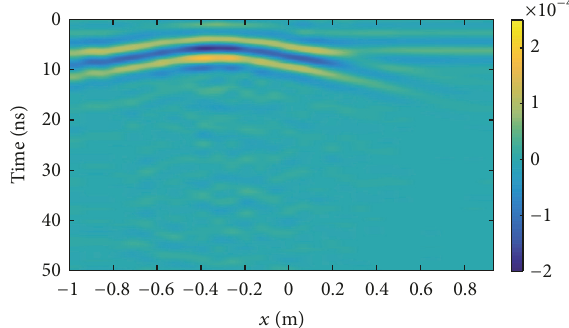
Figure 4: B-scan reporting the estimated field scattered by the buried object [96].